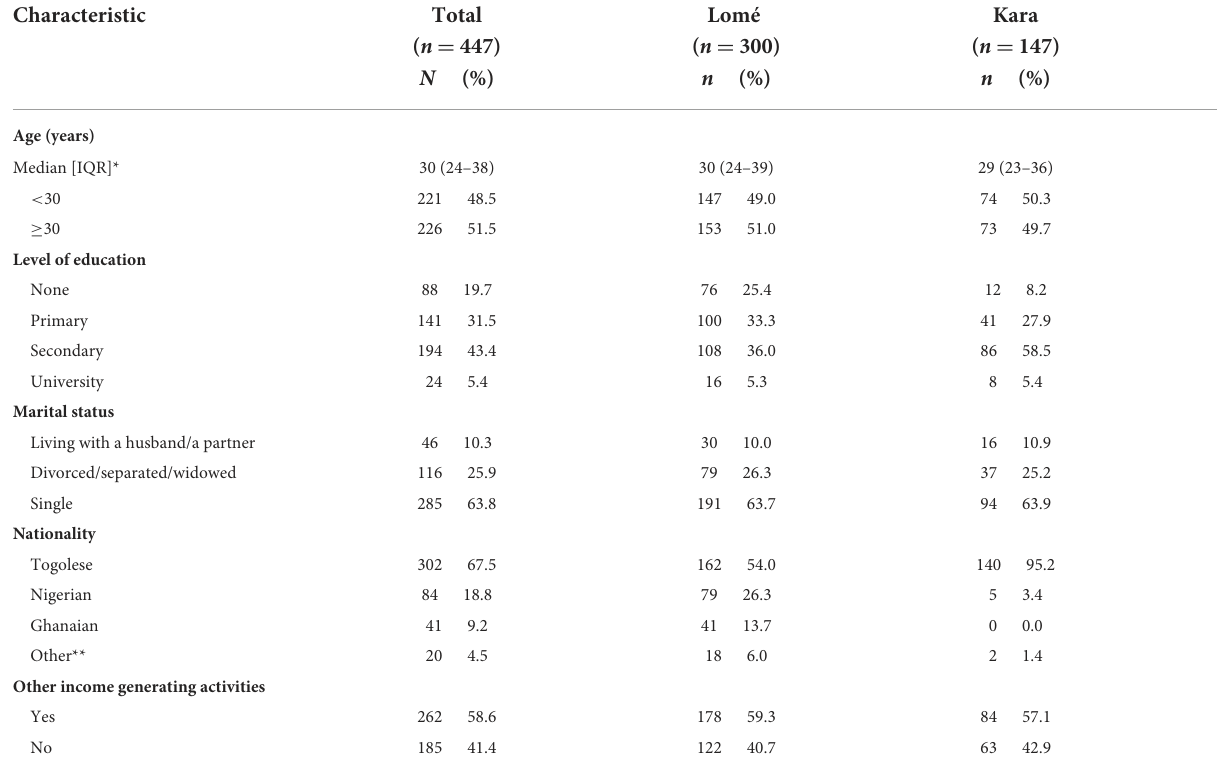
TABLE 1A Sociodemographic characteristics of female sex workers in Togo in 2021 ( N = 447).